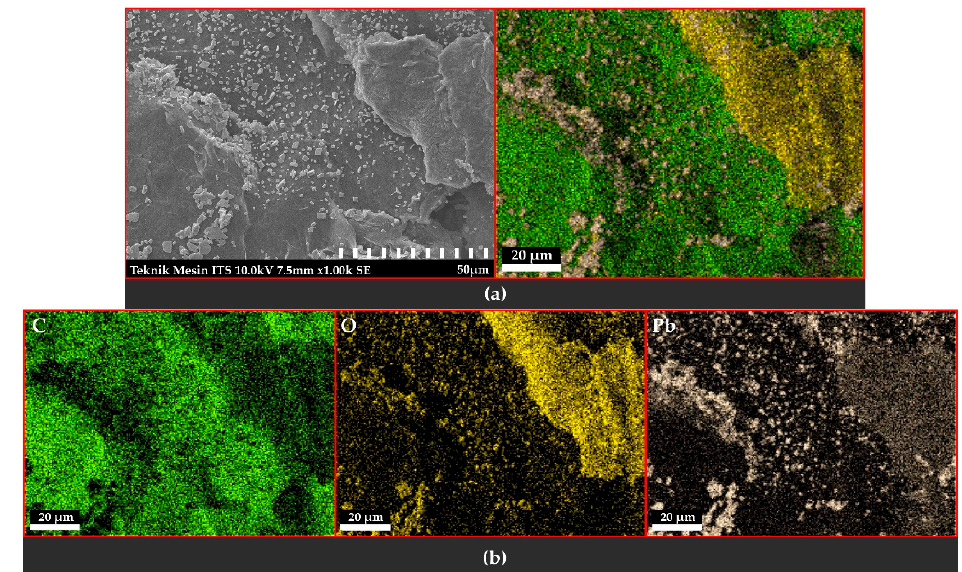
Figure 7. ( a ) Multi-element energy-dispersive X-ray spectroscopy mapping image. ( b ) Digital mapping image of elements C, O, and Pb at 12 V.